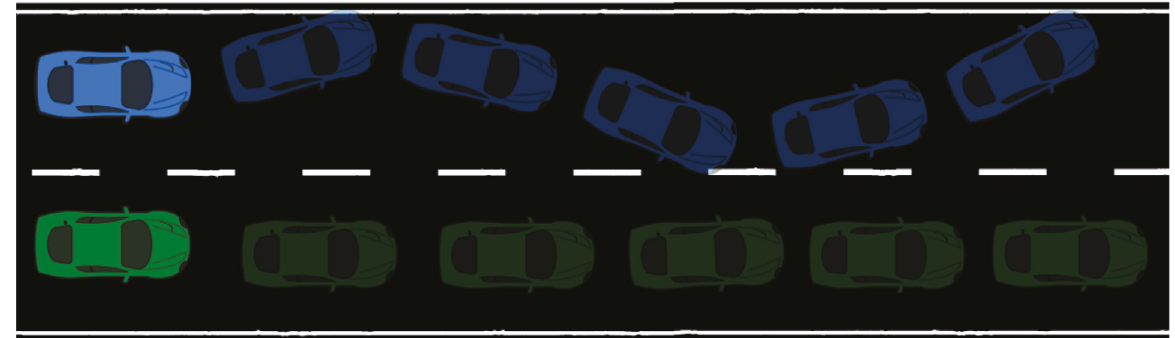
Figure 1: Comparison of OP lane-centering behavior (green) with that of most existing stock ADASs